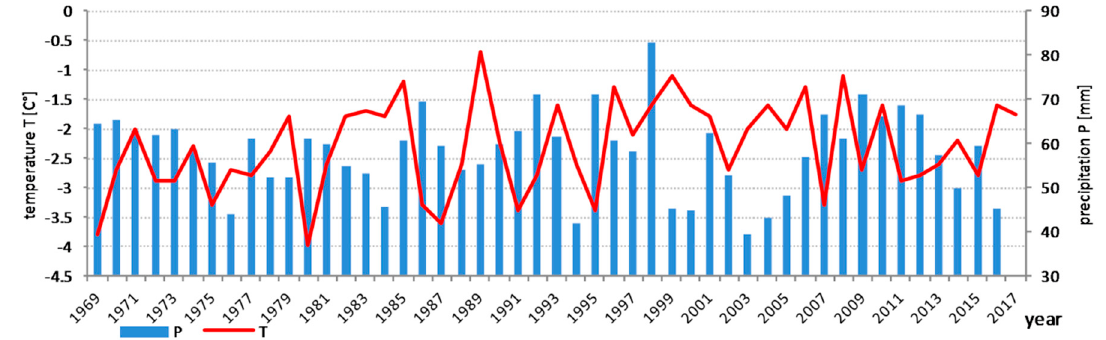
Figure 1. Mean annual air temperature and sum of the precipitation at Bellingshausen Station (Fieldes Peninsula) in the period 1969–2017 [15].